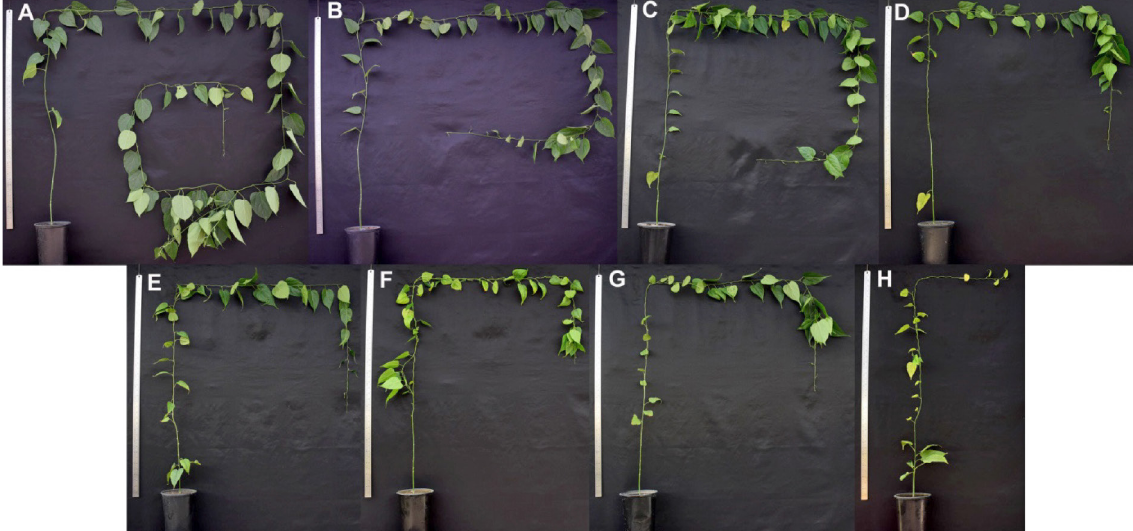
Fig. 4: Plants of the inka nut ( Plukenetia volubilis ), grown for 80 days in the greenhouse. A) Non-inoculated control; B) inoculated with Meloidogyne in- cognita ; C) inoculated with Fusarium solani ; D) inoculated with F. verticillioides ; E) simultaneously inoculated with M. incognita and F. solani ; F) simultaneously inoculated with M. incognita and F. verticillioides ; G) inoculated with F. solani 20 days after inoculation with M. incognita ; H) inoculated with F. verticillioides 20 days after inoculation with M. incognita , scale = 100 cm.